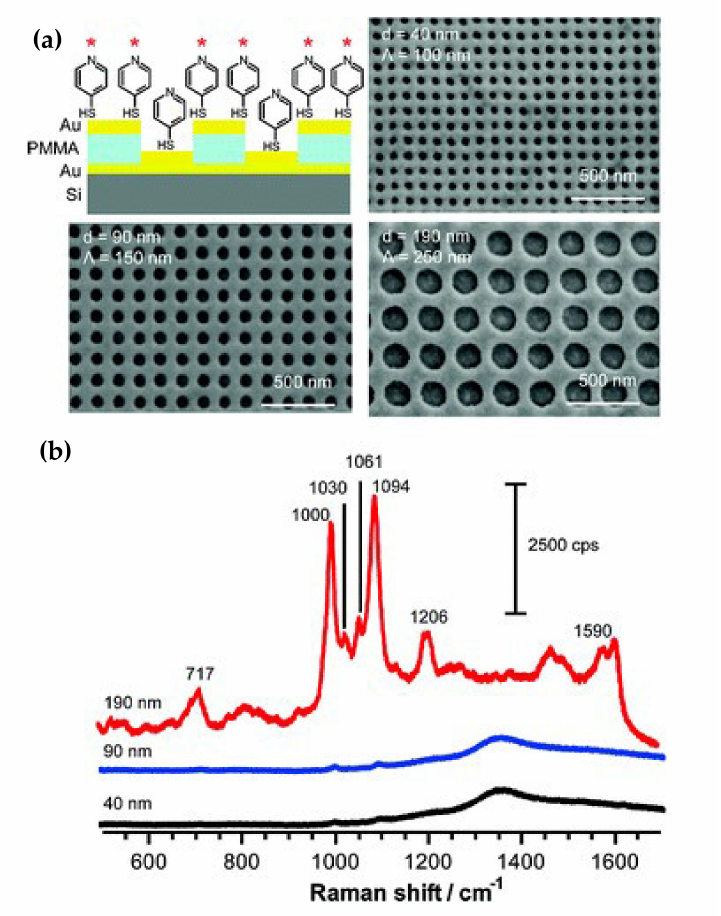
Figure 18. Surface-enhanced Raman scattering of gold nanohole array: ( a ) Schematic of side view of gold thin film with nanoholes and a physically separated layer of isolated gold disks at the bottom of the well. 4-MP molecules adsorbed on the surface with an asterisk to illustrate where the local electromagnetic field is enhanced. SEM images of three gold nanohole arrays with diameters of 40, 90, and 190 nm and the gratings of 100, 150, and 250 nm, respectively. The thickness of gold films is 50 nm. The depth of wells is ∼ 100 nm measured by tapping mode AFM. ( b ) SERS spectra of 4-MP adsorbed on three gold nanohole arrays with different diameters activated by a 785-nm laser. Reprinted with permission from Ref. [163]. Copyright 2008 American Chemical